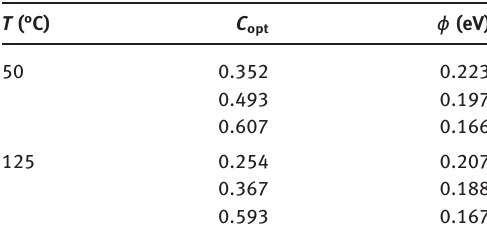
Table 2: Metallic indium concentration and barrier height values for two different